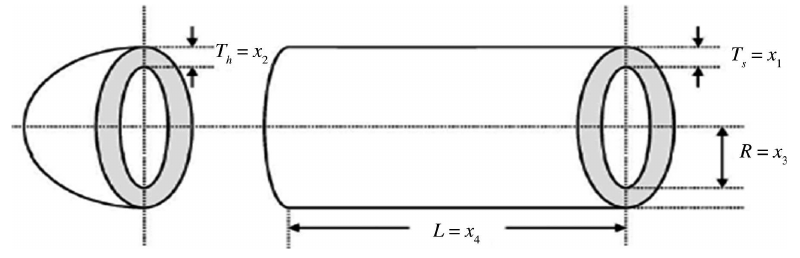
Figure 4: Pressure Vessel Design